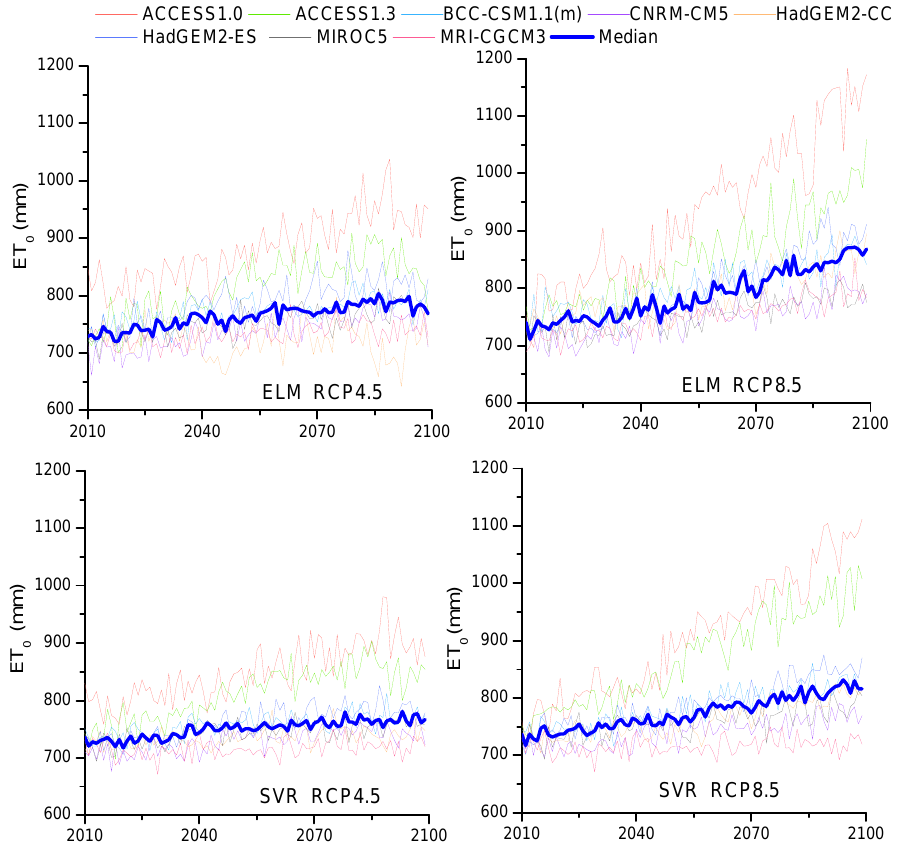
Figure 7. Results of future ET 0 projection derived from GCM outputs under the RCP4.5 and RCP8.5 scenarios.